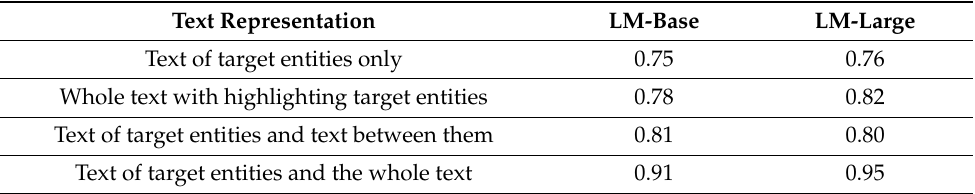
Table 5. Accuracies (by the f1-macro metric) of XLM-RoBERTa-base-sag (denoted “LM-Base”) and XLM-RoBERTa-large-sag (“LM-Large”) language models with different methods of text representation. Text Representation